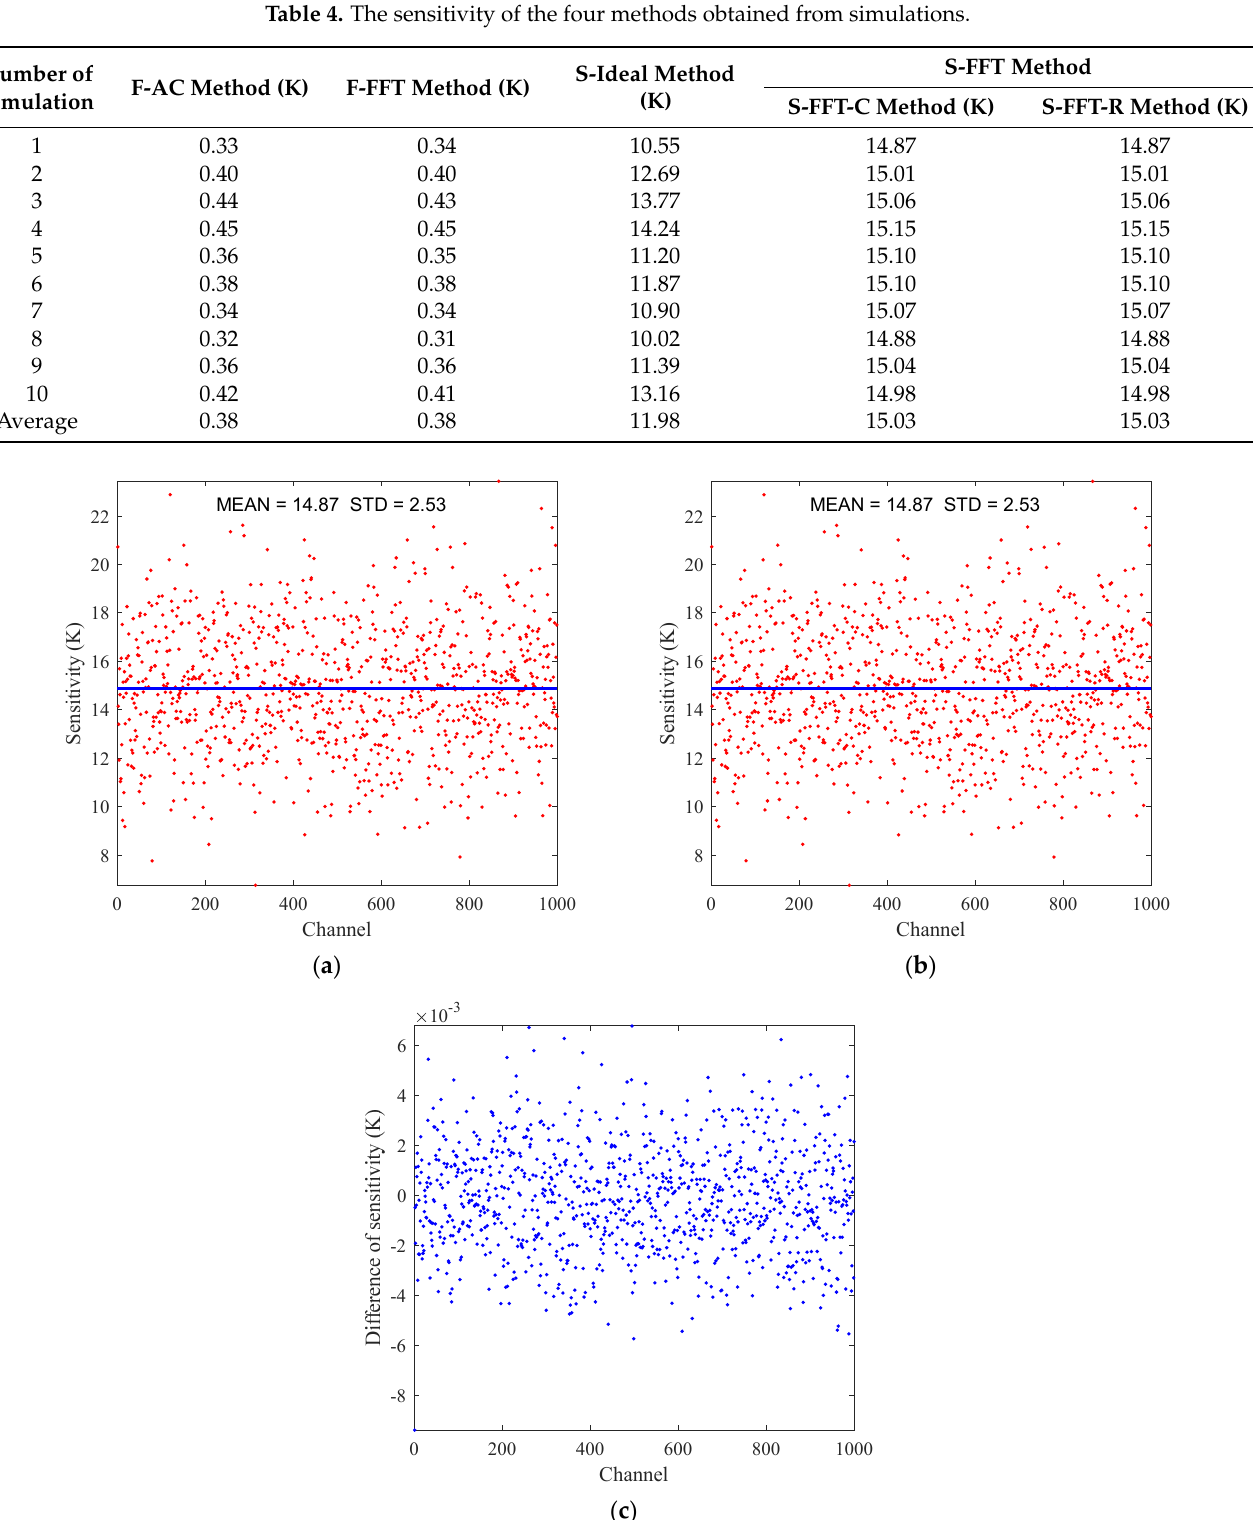
Figure 10. The sensitivity obtained by the S-FFT-C method and the S-FFT-R method after one of the simulations: ( a ) S-FFT-C method; ( b ) S-FFT-R method; ( c ) difference of sensitivity between the two methods for each channel.